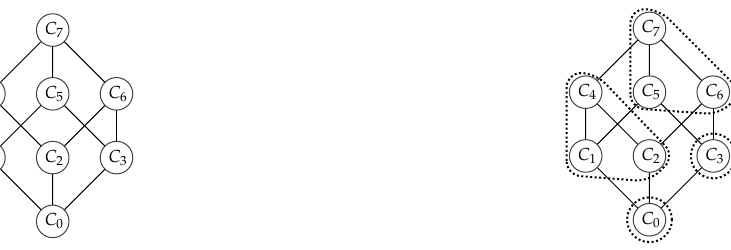
Figure 1. Concept lattice of Example 1 ( left ) and the partition induced by the elimination of attributes a 2 and a 3 in Example 1 ( right